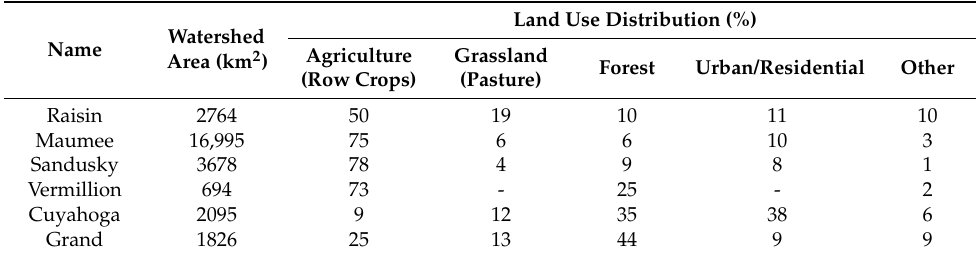
Table 1. Land use classification of the